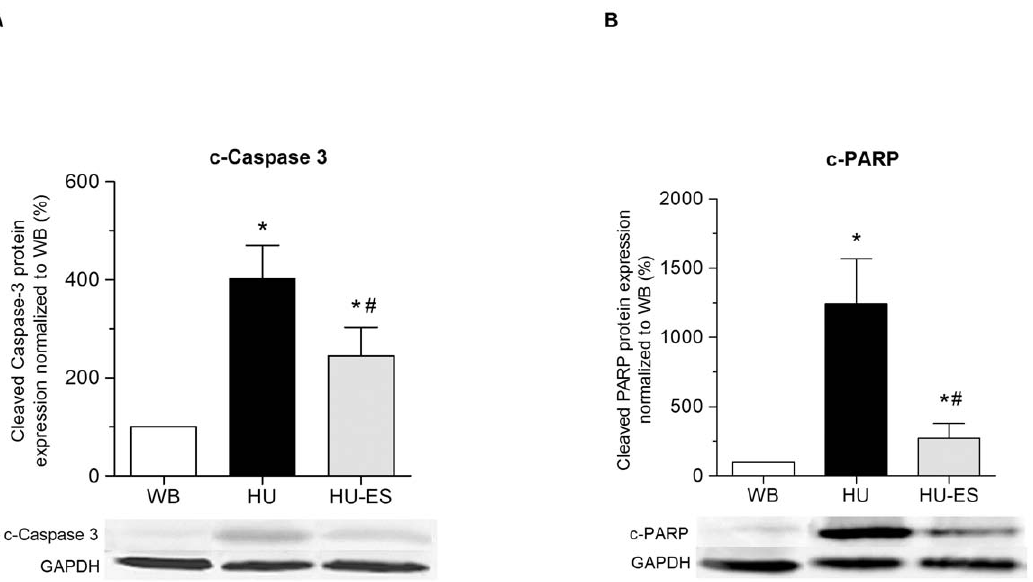
Figure 6. Expression levels of cleaved forms of caspase-3 and PARP in the soleus muscle obtained from weight-bearing (WB), hindlimb-unloading (HU), and electrically stimulated (HU-ES) groups. (A) Western blot analysis of expression of cleaved caspase-3. (B) Western blot analysis of expression of cleaved PARP. The relative protein levels were normalized to WB group. Representative immunoreactive bands were shown. *p , 0.05, significant difference compared to WB group; # p , 0.05, significant difference compared to HU group. Values are means 6 SEM.